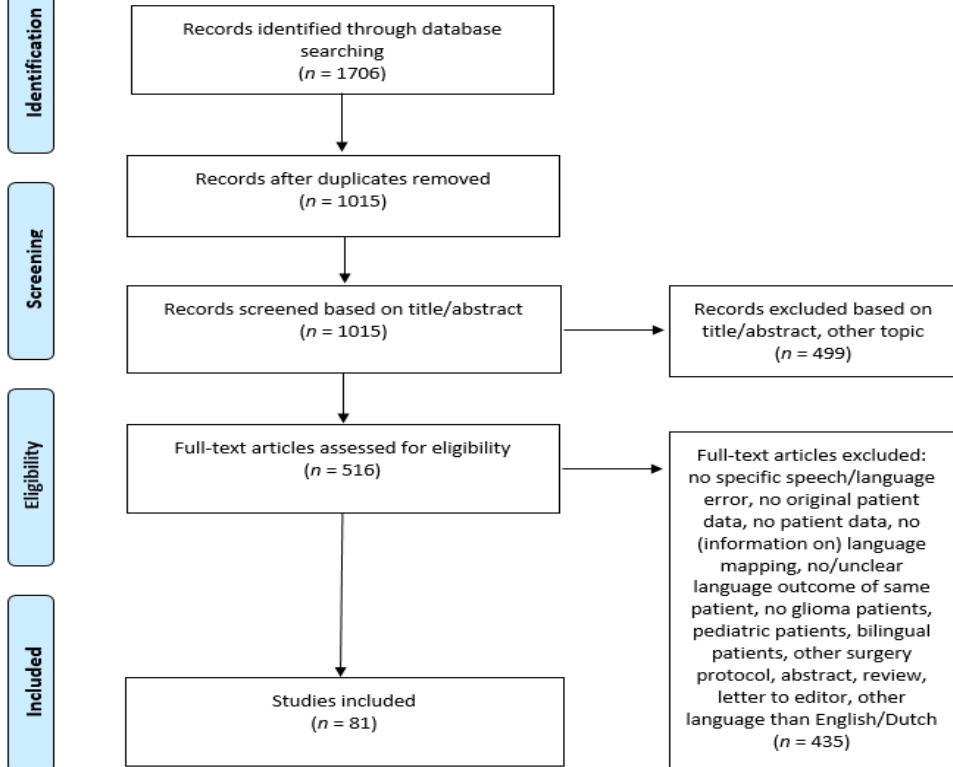
Figure 1. PRISMA flowchart of total records identified through searching of databases.